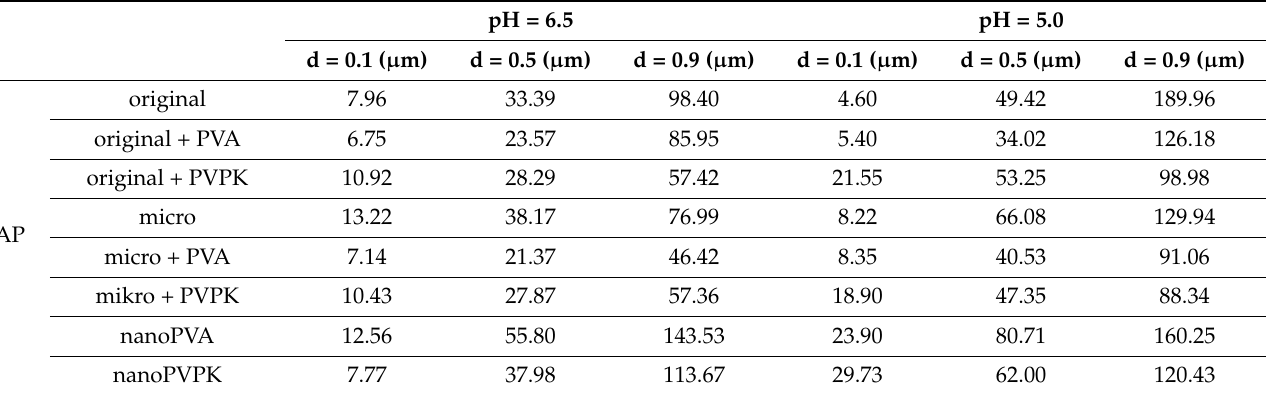
Table 3. Particle size distribution of the solid phase samples from the solubility measurements of papaverine